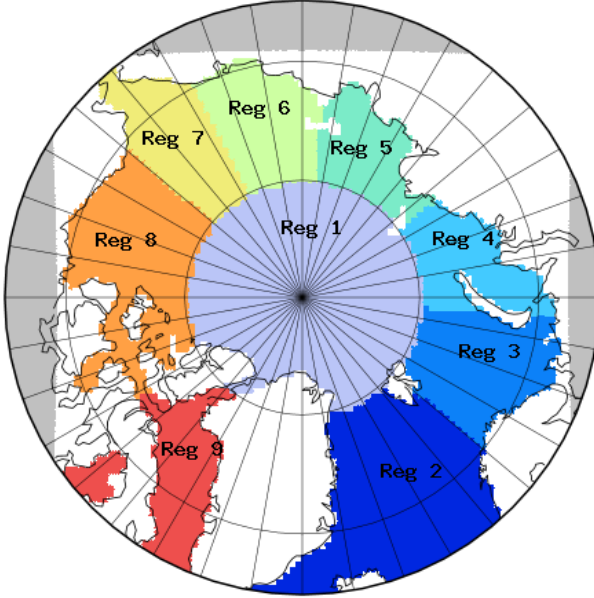
Figure 2. Sub-regions defined in the study. 1 (light plum): central Arctic. 2 (dark blue): North Atlantic; and then counterclockwise to 7 (yellow): Bering Strait/Chukchi Sea; 8 (orange): Beaufort Sea; 9 (red): Baffin